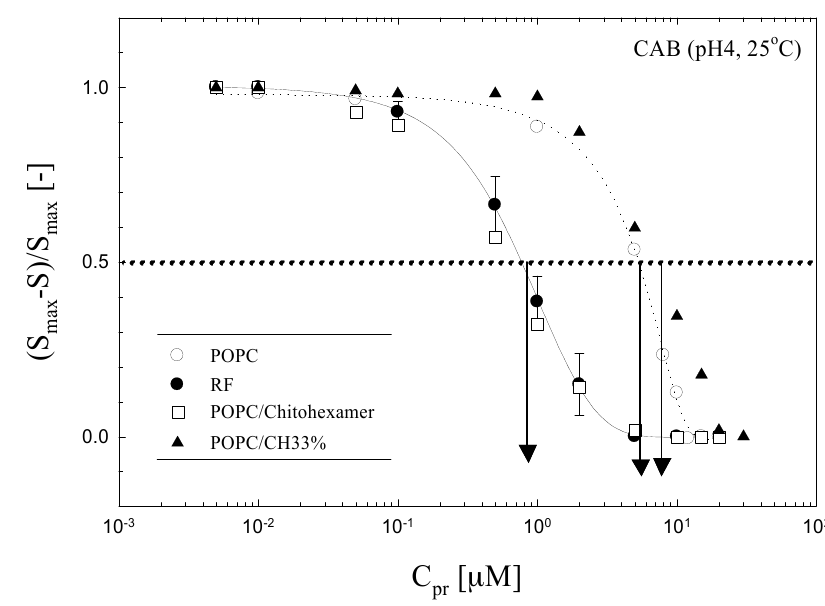
Figure 4. Response behavior of the electrolyte-loaded POPC, POPC/CHT and POPC/CH33 was shown as a function of CAB concentration (pH 4.0) and sensitivity. S is the maximum current of the film after injection the CAB; S max is the maximum current of the film after injection of the saturated concentration of CAB. As a control values, released fluorescent intensity (RF) is obtained the release of calcein from POPC liposome by using the fluorescent measurement.